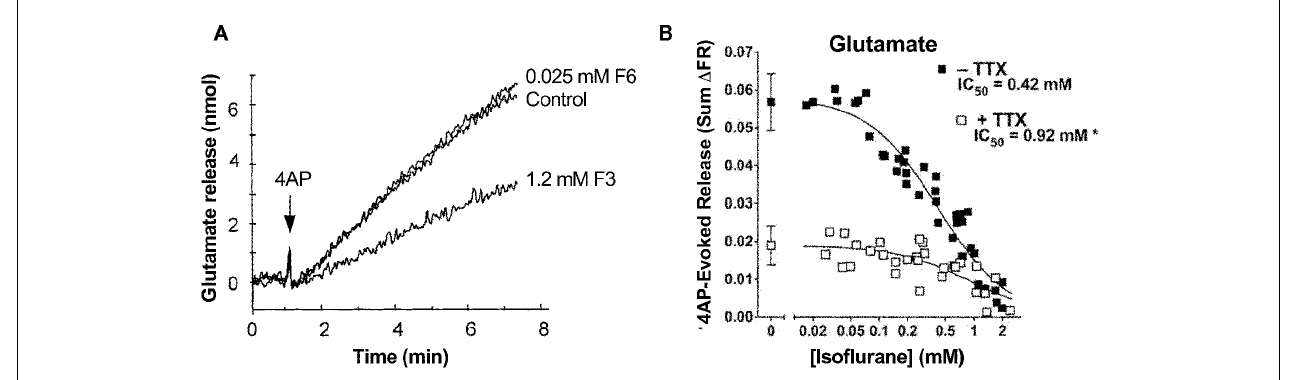
Isoflurane inhibition of 4AP-evoked glutamate release from rat cortical nerve terminals in the absence or presence of tetrodotoxin (TTX, 1 μ M). The potency of isoflurane inhibition is much greater in the absence of the Na + channel blockerTTX indicating a strong involvement of Na + channels in inhibition of neurotransmitter release by volatile anesthetics (Westphalen et al.,